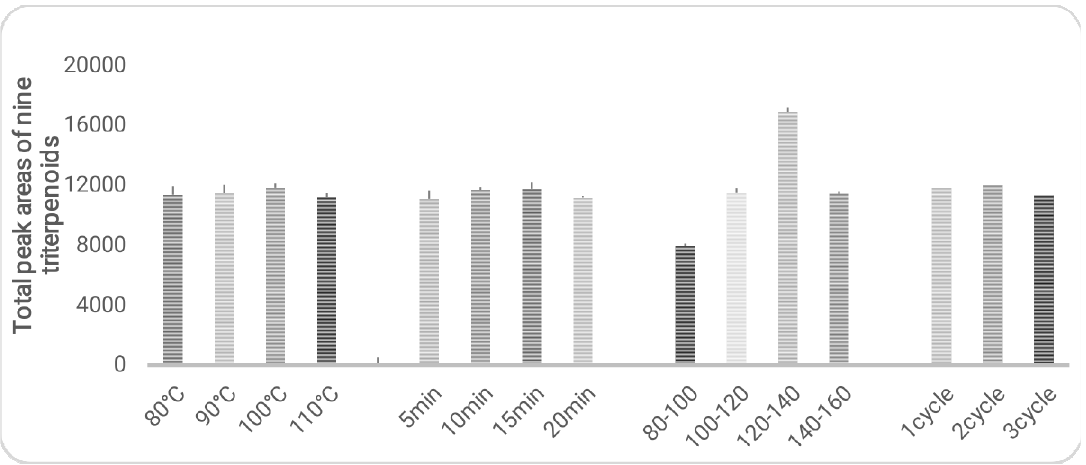
Figure 3. Influence of temperature, extraction duration, particle size and extraction cycles on extraction efficiency of PLE ( n = 3).